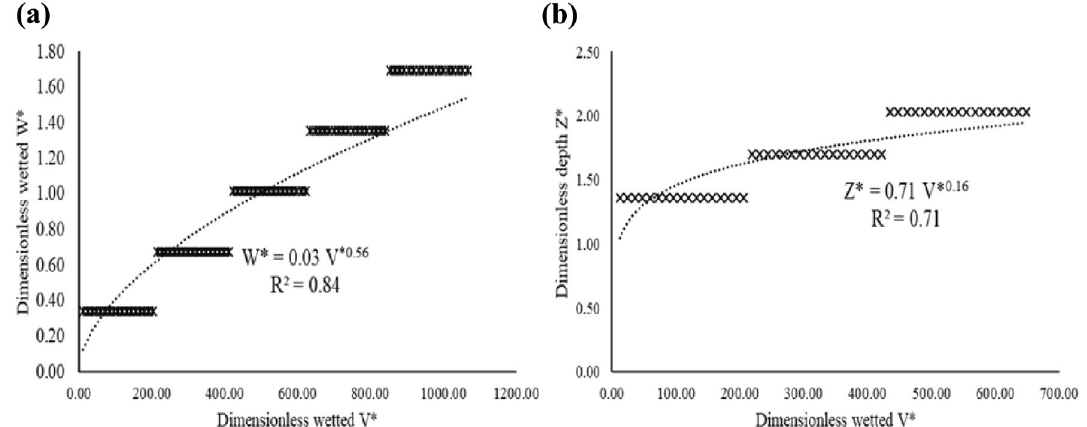
Figure 2. Relationship between ( a ) dimensionless wetted volume ( V ∗ ) and dimensionless wetted width ( W ∗ ) and ( b ) dimensionless wetted volume ( V* ) and dimensionless wetted depth ( Z ∗ ) for silty–clay-loam (the bars represented a cluster of data